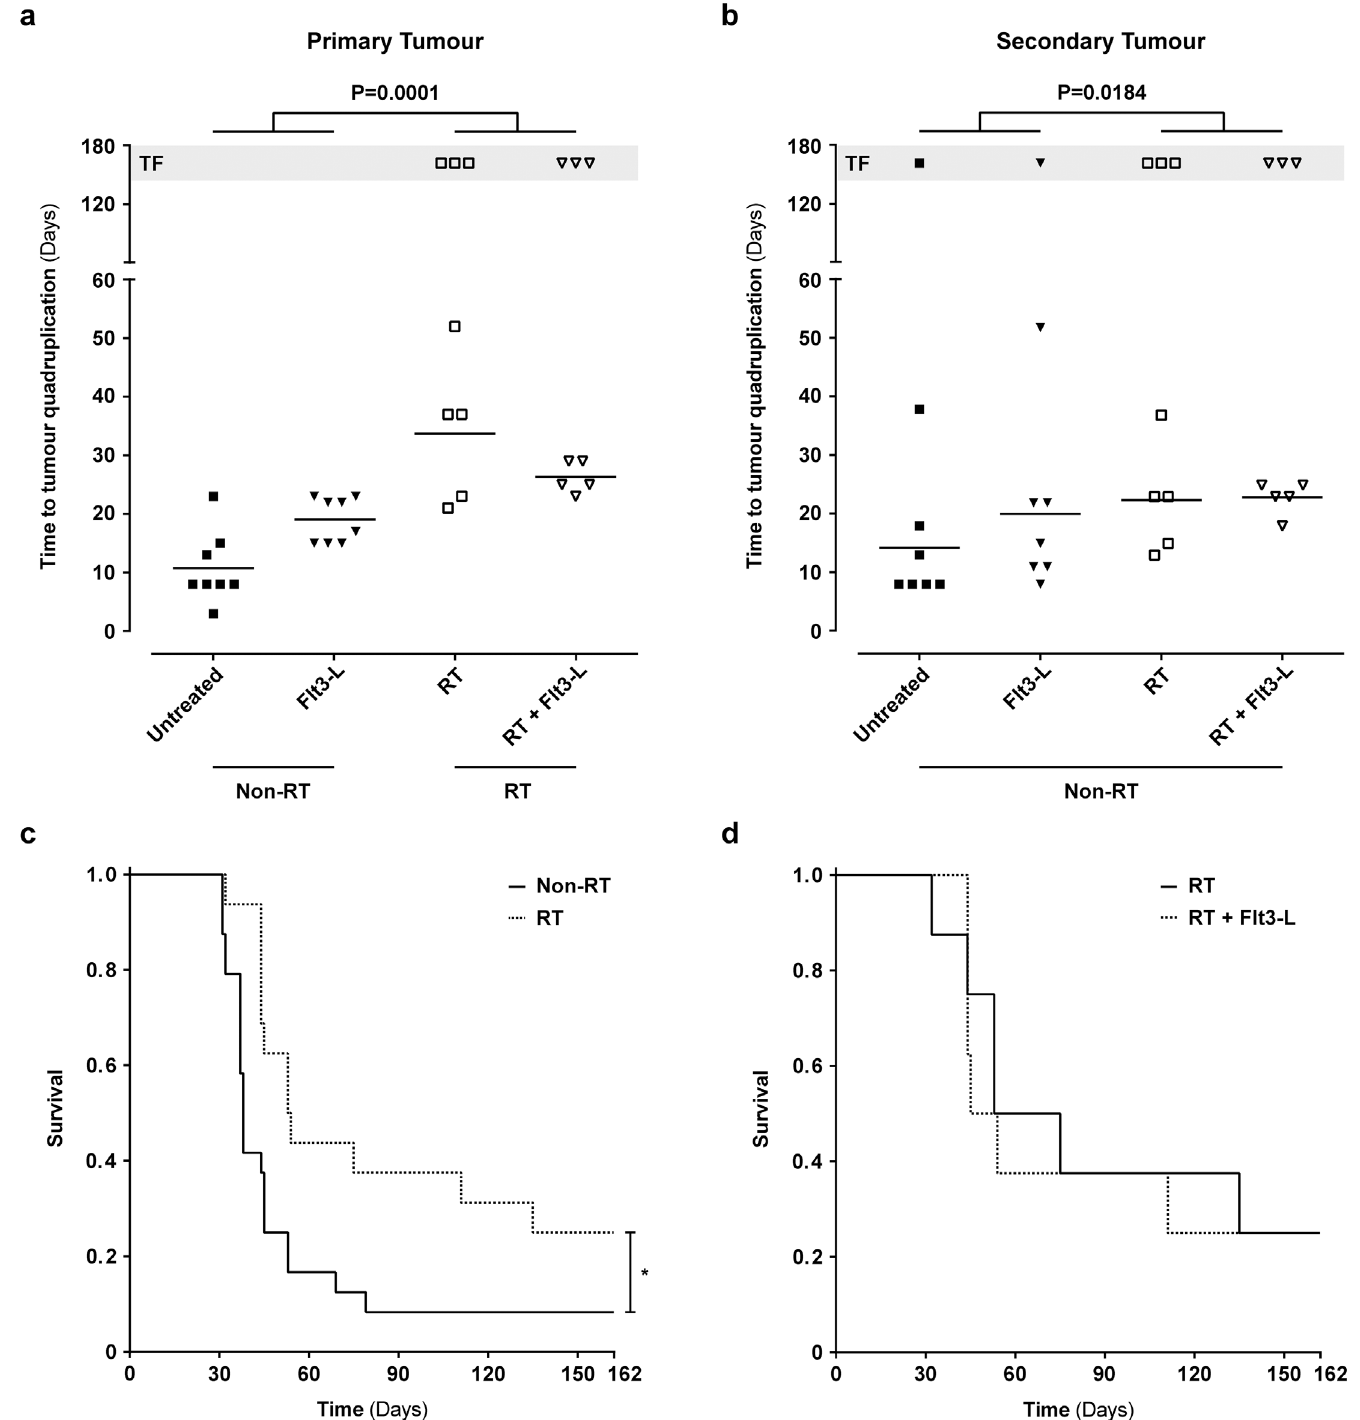
Fig 2. 67NR tumour growth and survival following treatment with RT and Flt3-L in tumour-bearing mice. a, b. Time (days) to reach quadruplication of the primary and secondary tumour as measure for 67NR tumour growth. The measurement started 14 days after inoculation of the 67NR tumours. The primary and secondary tumour of the RT groups showed a growth delay as compared to the non-RT groups (P < 0.05 * ) (TF: tumour free mice are excluded from Mann-Whitney t-test). c, d. The Kaplan-Meier survival curves of the (un)-treated animals. The non-irradiated (non-RT) animals were untreated or received injections of Flt3-L (10 days). The irradiated (RT) animals received RT (3 x 8Gy) or RT+Flt3-L (3 x 8Gy + 10 days). Log-rank (Mantel-Cox) test P < 0.05 * .